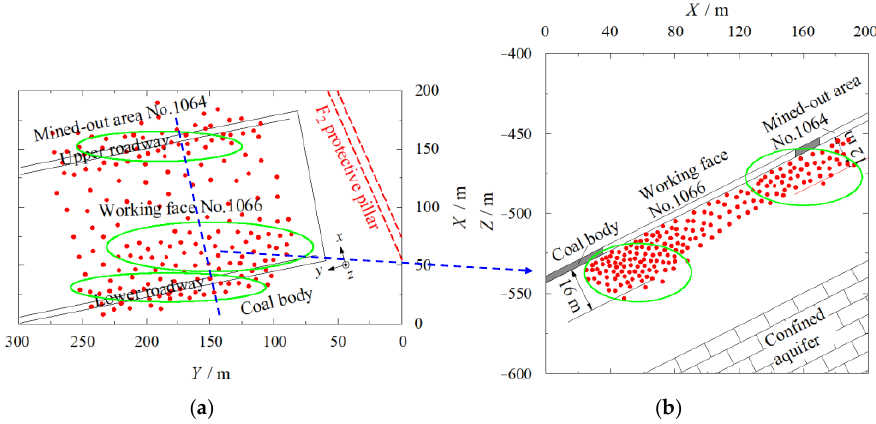
Figure 13. Results of micro-seismic monitoring of floor failure by Sun et al. [48]. ( a ) Top view; ( b ) Profile view along the inclination.